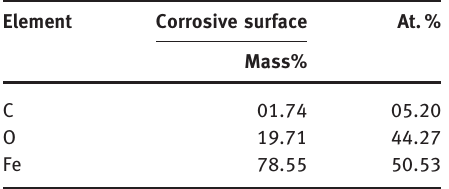
Figure 4: SEM micro- graph showing the (a) corrosive surface and the (c) EDS analysis of dis- tinct areas: (b) products near the crack of the corrosive specimen at 948.15K/100MPa.